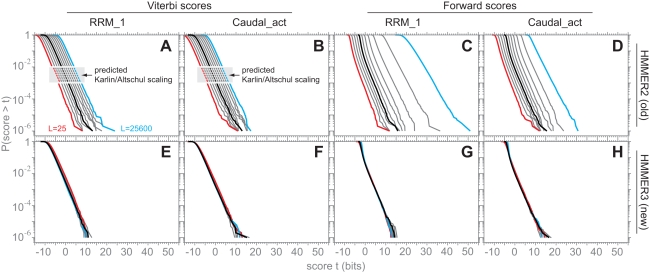
Target length modeling makes distributions length-independent.Log survival plots for multihit local Viterbi scores (left; [A,B,E,F]) and multihit local Forward scores (right; [C,D,G,H]) for the two “typical” models RRM_1 and Caudal_act, for n = 106 i.i.d. random sequences of various lengths, for either old HMMER2 scoring (top; [A–D]) or the new target length model in prototype HMMER3 (bottom; [E–H]). Eleven target sequence lengths are used, ranging from 25 to 25,600 in steps of two-fold, with L = 25 shown in red, L = 400 shown in black, L = 25,600 shown in cyan, and other lengths shown in grey. Each line is the observed log survival plot, collected in 0.1 bit intervals. The grey inset in the HMMER2 Viterbi scores (A,B) shows the length dependence predicted by Karlin/Altschul statistics, with location increasing by one bit for each doubling in target sequence length. The HMMER3 results (bottom; [E–H]) show that both Viterbi and Forward scores are essentially independent of target sequence length in the new parameterization of the target length model, even for the previously problematic multihit Forward scores.